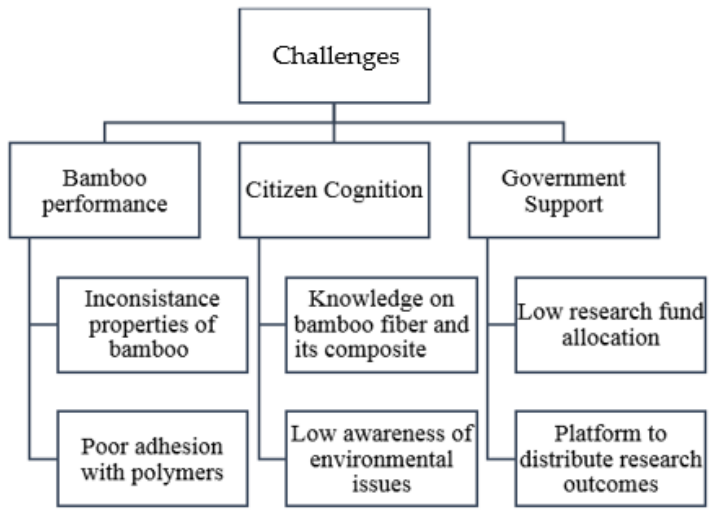
Figure 4. Challenges faced by bamboo composites worldwide.